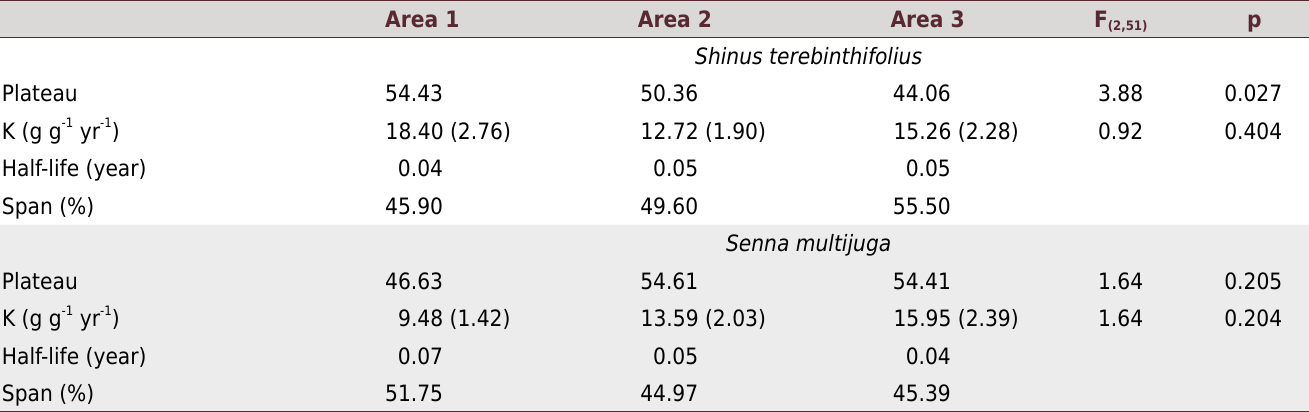
Table 2. Simple Exponential Decay summary for areas and plant species in the litter bags